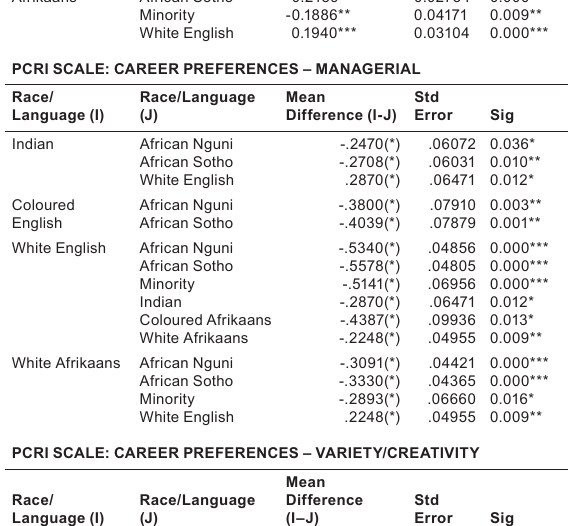
Table 7 Summary of Scheffé multiple comparison tests: Significant group mean differences on career values scale (N = 2 997) PCri sCale: Career Values –